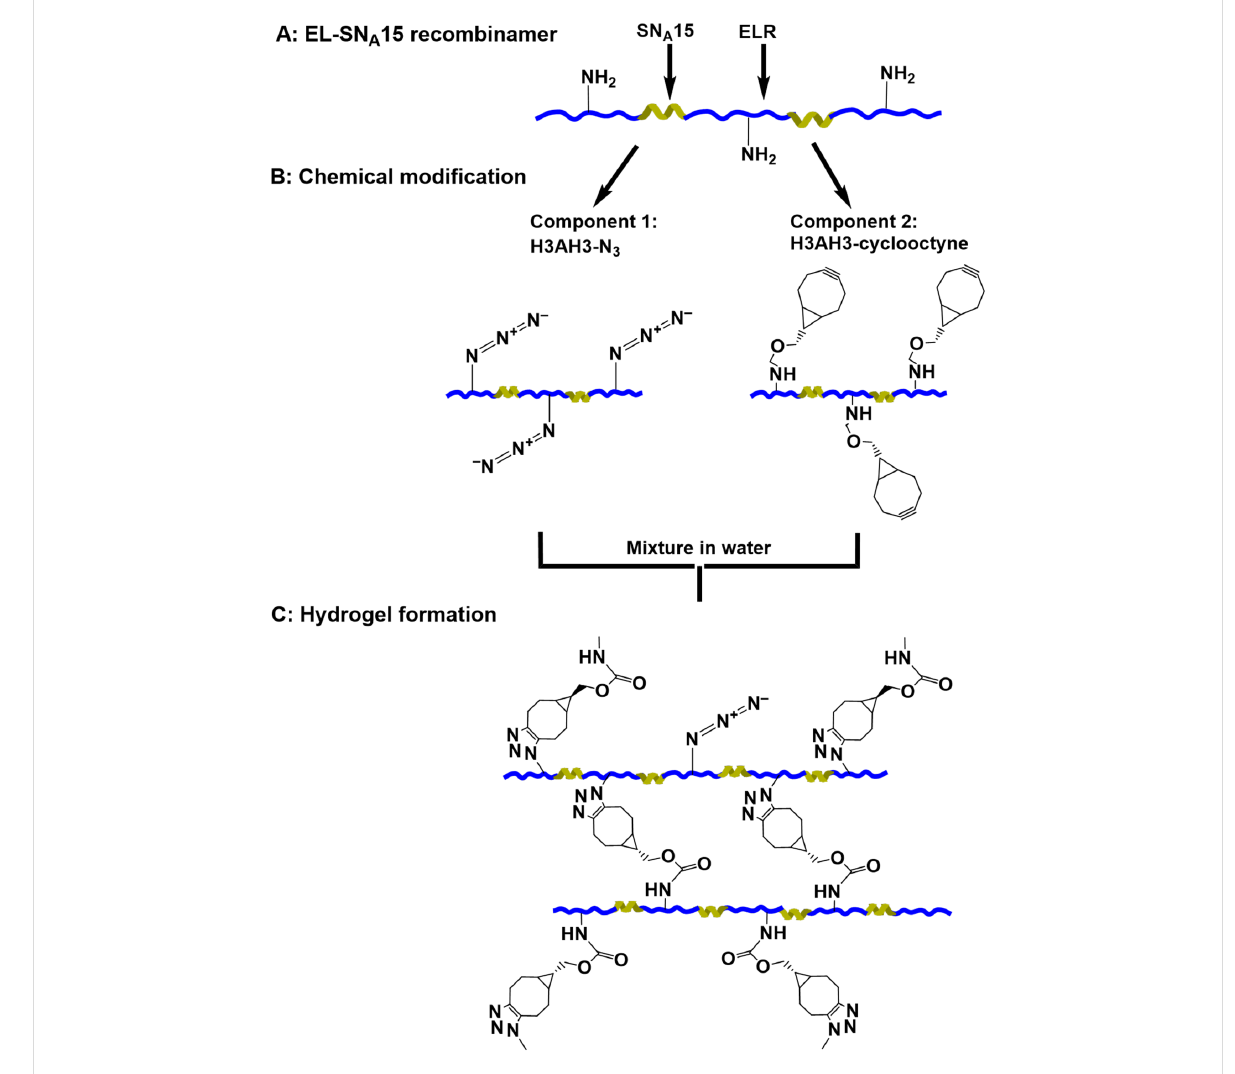
Figure 1: Schematic representation of (A) the H3AH3 recombinamer, (B) azide- (component 1) and cyclooctyne-derivatized H3AH3 (component 2), and (C) formation of the hydrogels via Huisgen [2 + 3] cycloaddition (“click” reaction).